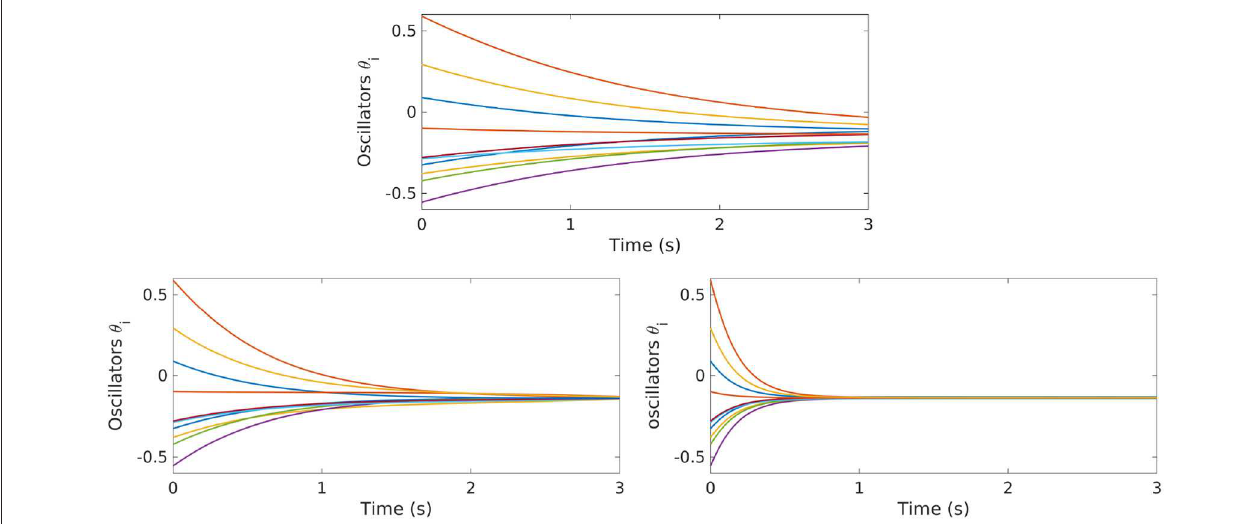
10 oscillators. Bottom : Evolution of the controlled dynamics of the = u is obtained with the GD (left) and the GD-RBM (right) approach. 10 oscillators. The control function = b